Question: Looking at the figure, what chart type is it?
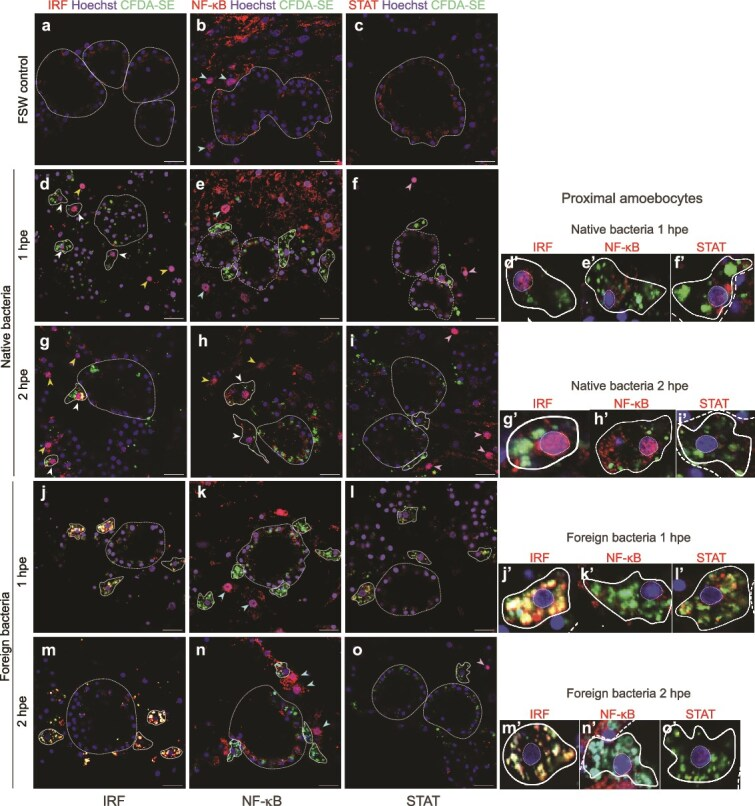
Answer: bar